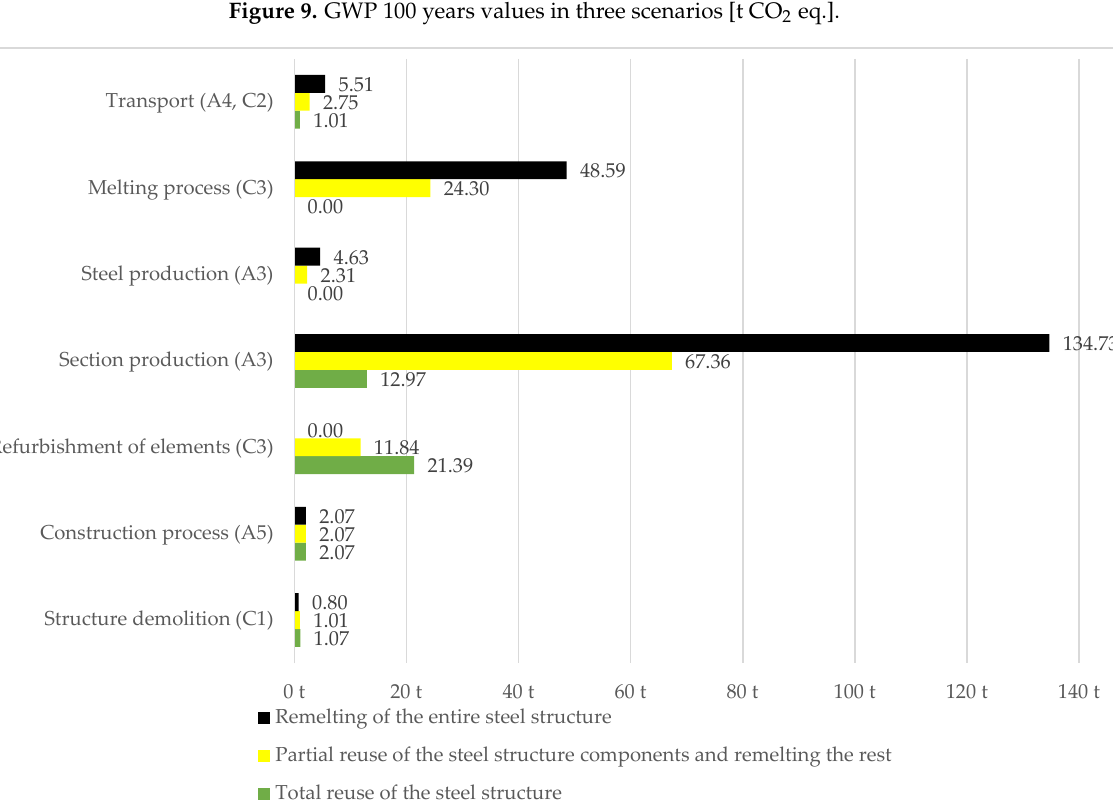
Figure 10. Global Warming Potential in processes (GWP 100 years) [t CO 2 eq.].